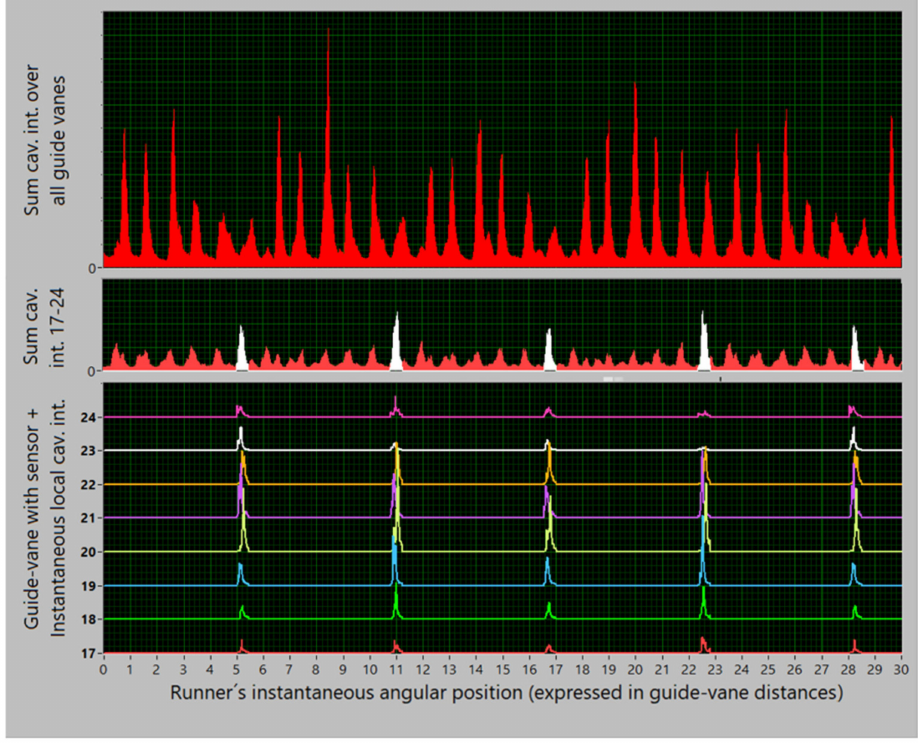
Figure A4. All as in Figure A3 but with extracted segments which surely belong to the rotating mechanism. Four peaks with Φ within a revolution (0–24), describe the four runner blades.